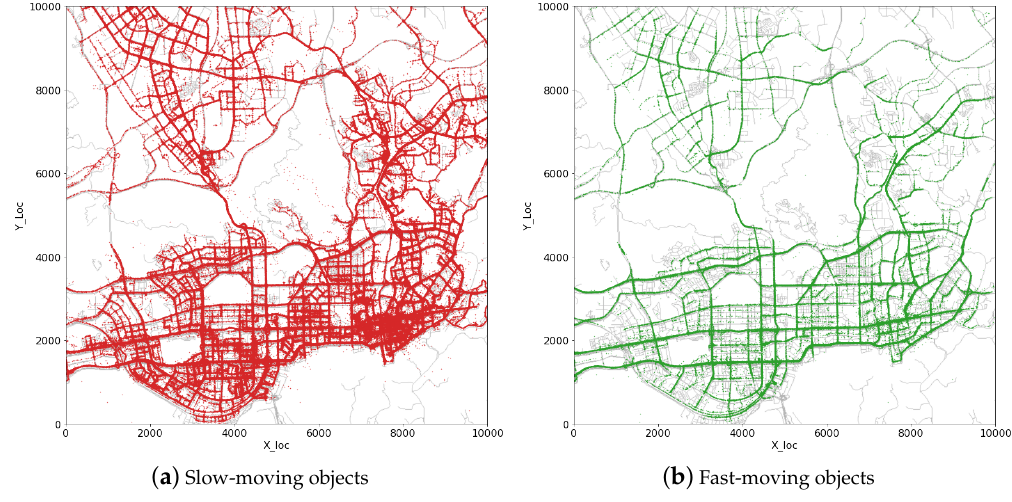
Figure 6. Sampled objects classified according to their